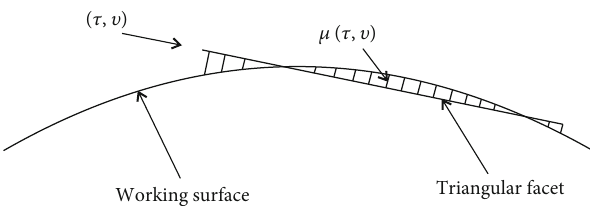
Figure 11: The desired working surface and a triangular facet for calculation of direct RMS